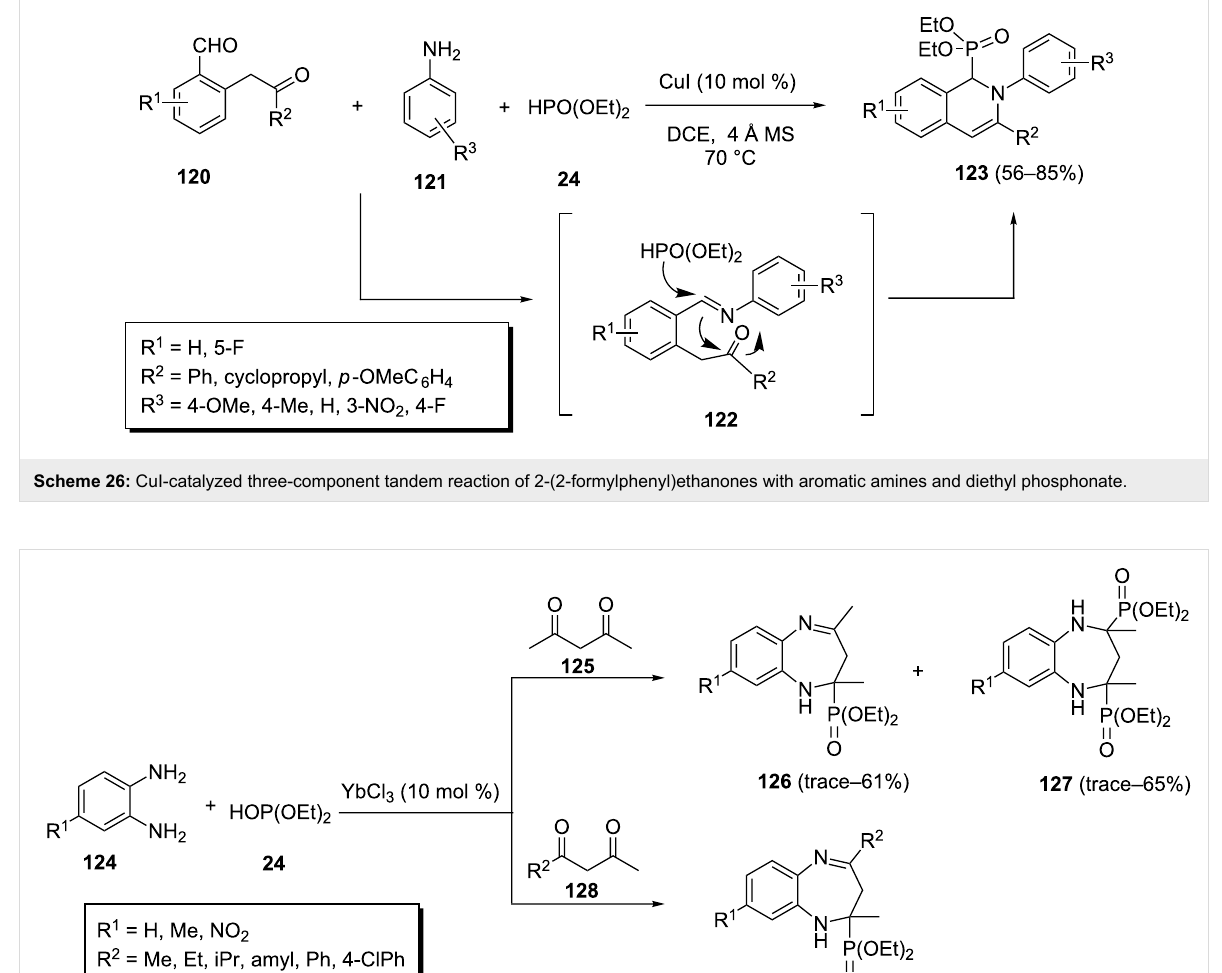
Scheme 25: Three-component synthesis of N -arylisoquinolone-1-phosphonates 119 .